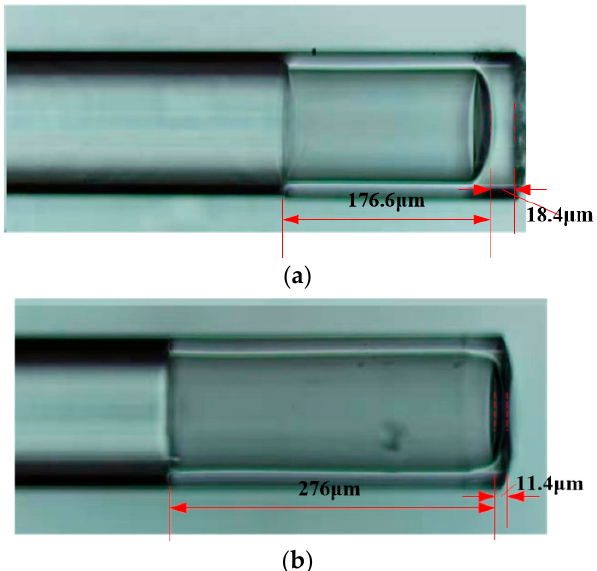
Figure 6. Fabricated fiber Fabry-Perot sensors. ( a ) Sample S1: cavity of short length; and ( b ) sample S2: cavity of long length.